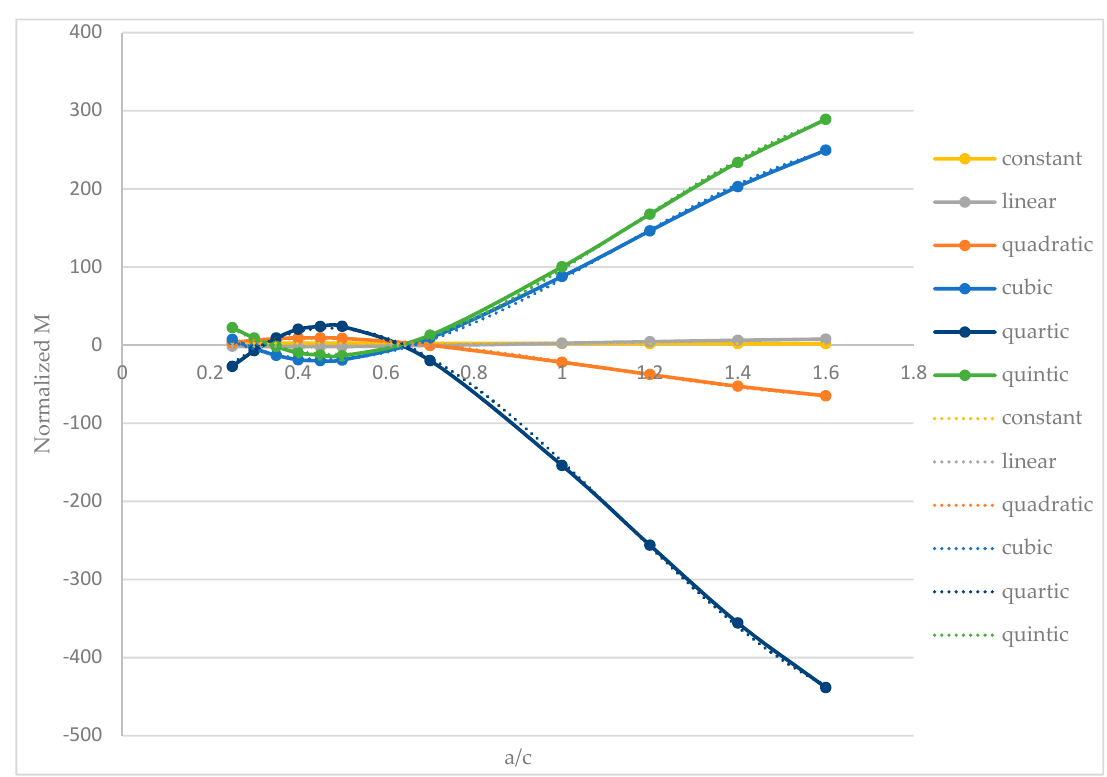
Figure A2. Polynomial fitting curves of the normalized M functions of Equation (18) for different initial external circumferential crack aspect ratios. The dotted lines indicate the fitting curves and the goodness of fit indicate more than 99%.